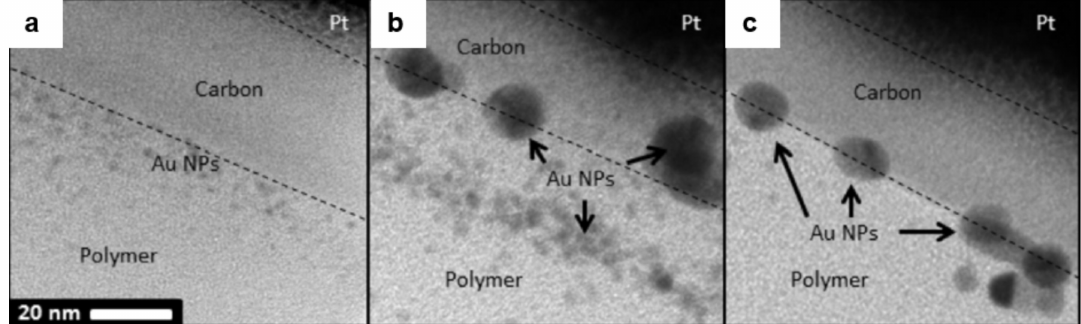
Figure 12. TEM bright-field cross-sectional images of Au-NP-functionalized SU-8 films prepared using the reducing agents ( a ) NaBH 4 , ( b ) sodium citrate, and ( c ) hydroquinone. Reprinted with permission from Ref. [114] Copyright 2014